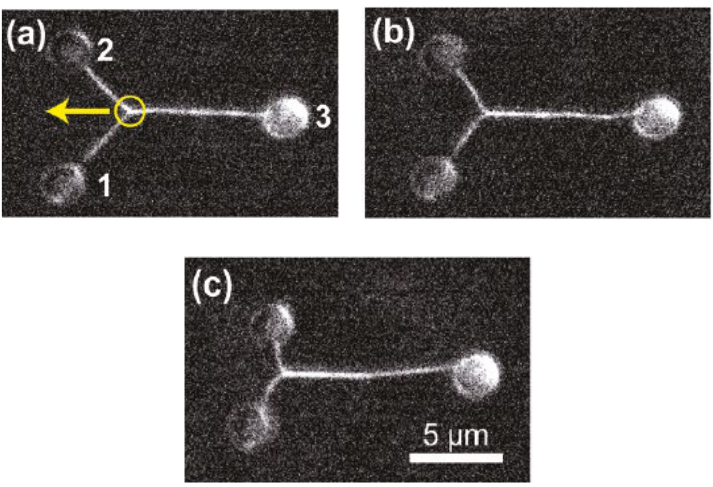
Figure 12. Two single actin filaments during bundle formation [127]. ( a – c ) Sequential fluorescence images of the bunding filaments. Yellow circle indicates the attachment between filaments, yellow arrow indicates the bunding axis.